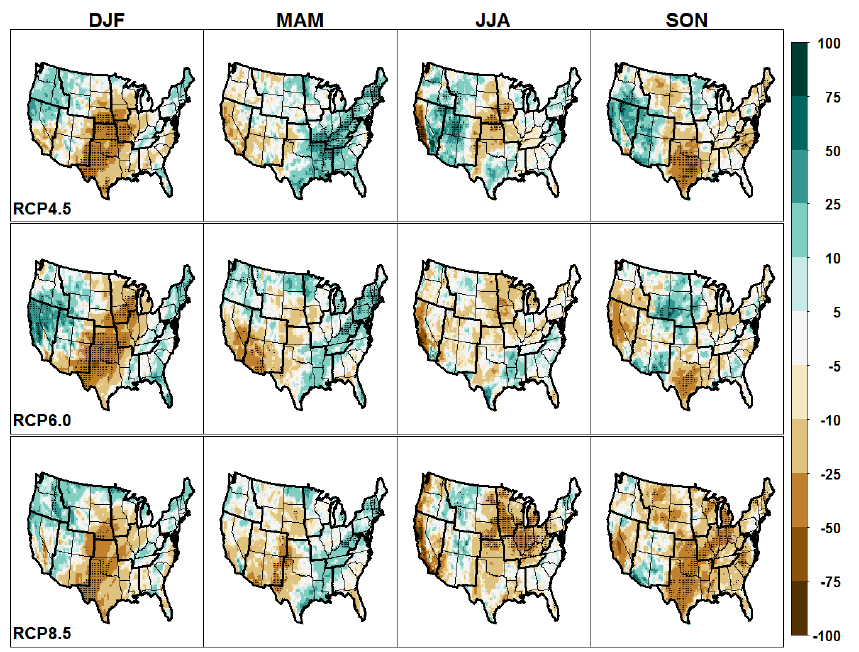
Figure 11. Relative changes projected in seasonal accumulated precipitation (%) from 1995–2005 to 2025–2035 under RCP4.5, RCP6.0, and RCP8.5. Dark pixels indicate where differences are significant according to Student’s t test ( p < 0 .